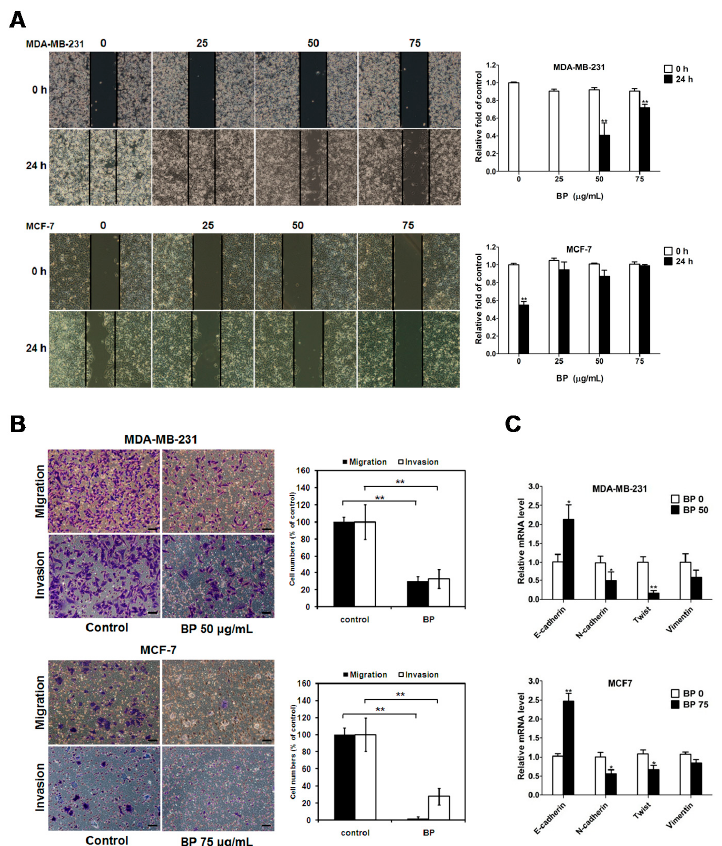
Figure 3. Effects of BP on the migratory and invasive ability on human breast cancer cells. ( A ) Wound healing assay: BP inhibits human breast cancer cell migration in a dose-dependent manner. Images of wound closures were captured using a microscope with ×100 magnification; scale bar: 100 μ m. The cell-free area invaded by migrated cells across the black lines were calculated by three randomized fields and quantified. The cell-free distance at 0 h were set at 100%; ( B ) Human breast cancer cells were pretreated with BP for 24 h, then seeded onto the trans-well hanging insert coating with (invasion) or without (migration) matrigel for 24 h. Images were captured using an inverted microscope with ×200 magnification; scale bar: 50 μ m. The migration and invasion of human breast cancer cells were quantified by enumerating the stained cells that migrated into the underside of the hanging insert membrane; ( C ) Human breast cancer cells were treated with BP for 24 h, and the mRNA expression levels of E-cadherin, N-cadherin, Twist, and vimentin were determined by qRT-PCR analysis. Data are presented as means ± S.D. from three different experiments. * p < 0.05 vs. vehicle; ** p < 0.01 vs. vehicle.